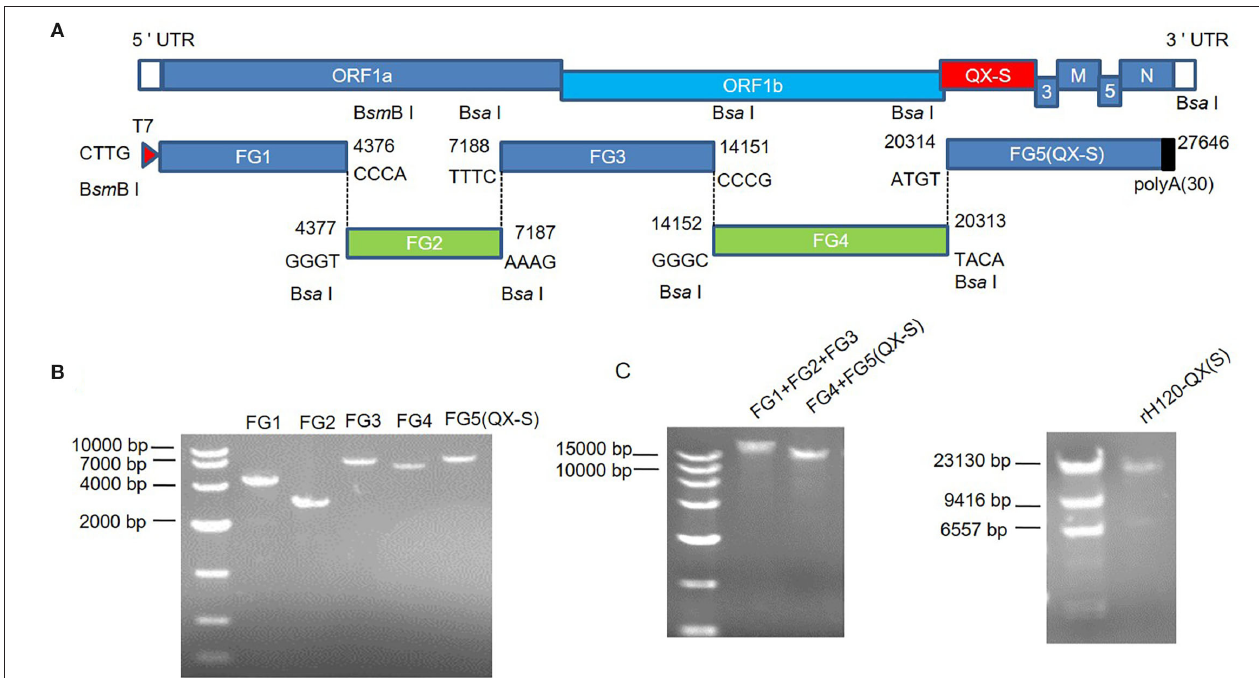
FIGURE 1 | In vitro assembly of a full-length rH120-QX(S) infectious cDNA clone. (A) The schematic diagram for in vitro assembly of an infectious cDNA clone of rH120-QX(S). The genetic organization of rH120-QX(S) and the replacement of the H120S gene with the QX S gene for the construction of rH120-QX(S) are shown. Five cDNA fragments covering the entire genome of the rH120-QX(S) strain were amplified by RT-PCR and cloned into the vector; the nucleotide sequence and location in the genome of the cohesive overhangs are indicated. A unique T7 promoter sequence was added at the 5’-terminus of FG1, and a poly-A (30A) tail was added at the 3’-terminus of FG5. The terminal sequence of each cDNA fragment was franked with restriction enzyme sites B sa I or B sm B I. (B) The five fragments were cleaved from the plasmids and separated by agarose gel electrophoresis. (C,D) The intermediate ligation products [FG1 + FG2 + FG3 and FG4 + FG5(QX-S)]. (C) and full-length cDNA of H120-QX(S) (D) were examined with agarose gel